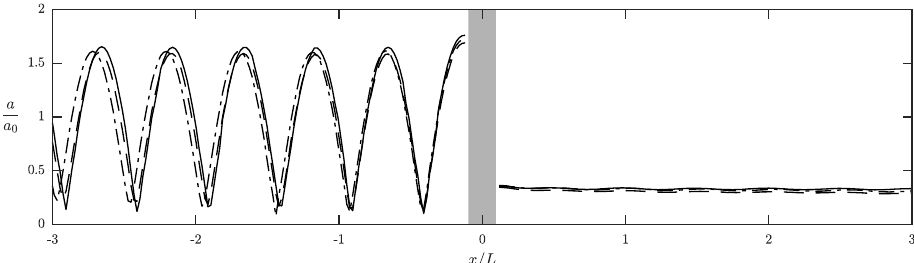
Figure 8. Effects of mud layer thickness on wave scattering by a surface obstacle: spatial variation of wave amplitude ratio, a / a 0 . Solid line: d m = 0 (solid bottom). Dashed line: d m = δ m . Dashed-dotted line: d m = 3 δ m . Shaded box denotes the surface obstacle. In this case, T = 1.79 s, a 0 = 0.02 m, d = 0.8 m, ν m = 0.003 m 2 /s, ρ m = 1111 kg/m 3 , L o = 0.8 m, and D o = 0.4 m. See Figure 1a for